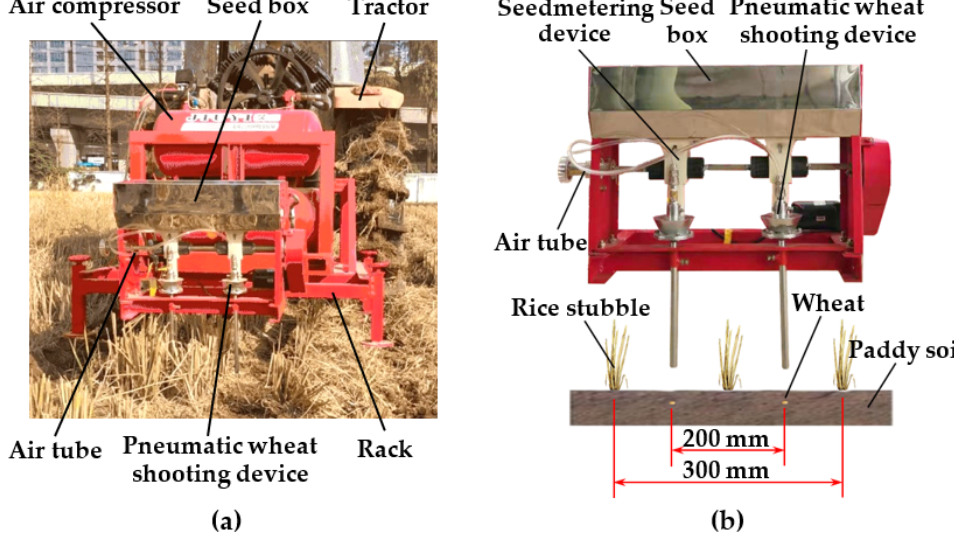
Figure 6. ( a ) Structure of principle prototype of pneumatic wheat-shooting. ( b ) Pneumatic wheat- shooting scheme in the